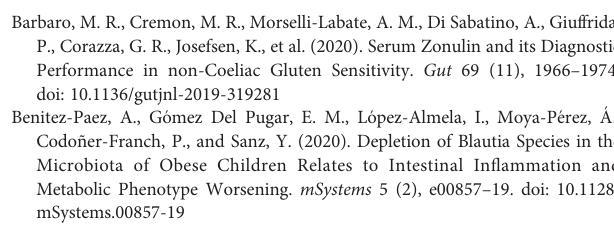
Supplementary Figure 1 | Rarefaction curve: the abscissa represents the number of randomly selected sequences, and the ordinate represents the number of OTUs (A) . Each curve represents a sample, all rarefaction curves reached plateaus, suggesting accurate sequencing depth. Thelevel of similarity between the fecal microbial communities detected in the frail and control groups was assessed using an unweighted Analysis of similarity (ANOSIMs) (B) . These analyses revealed the (C) top 8 most abundant phyla and the (D) top 20 most abundant genera between the frail and control